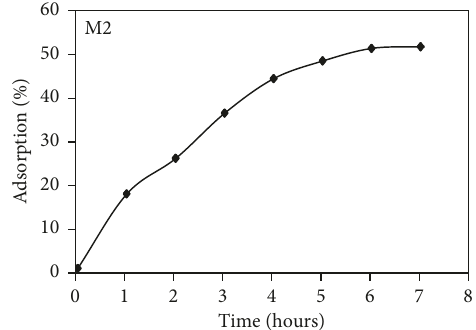
2 NP, and Figure 5: Effect of time on the adsorption process of